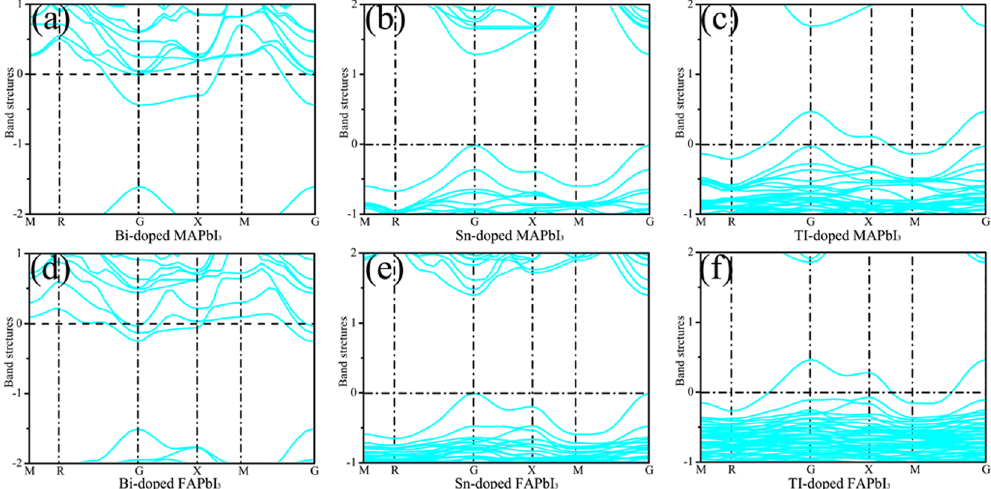
Figure 2. The band structures of the ( a ) Bi-doped MAPbI 3 , ( b ) Sn-doped MAPbI 3 , ( c ) TI-doped MAPbI 3 , ( d ) Bi-doped